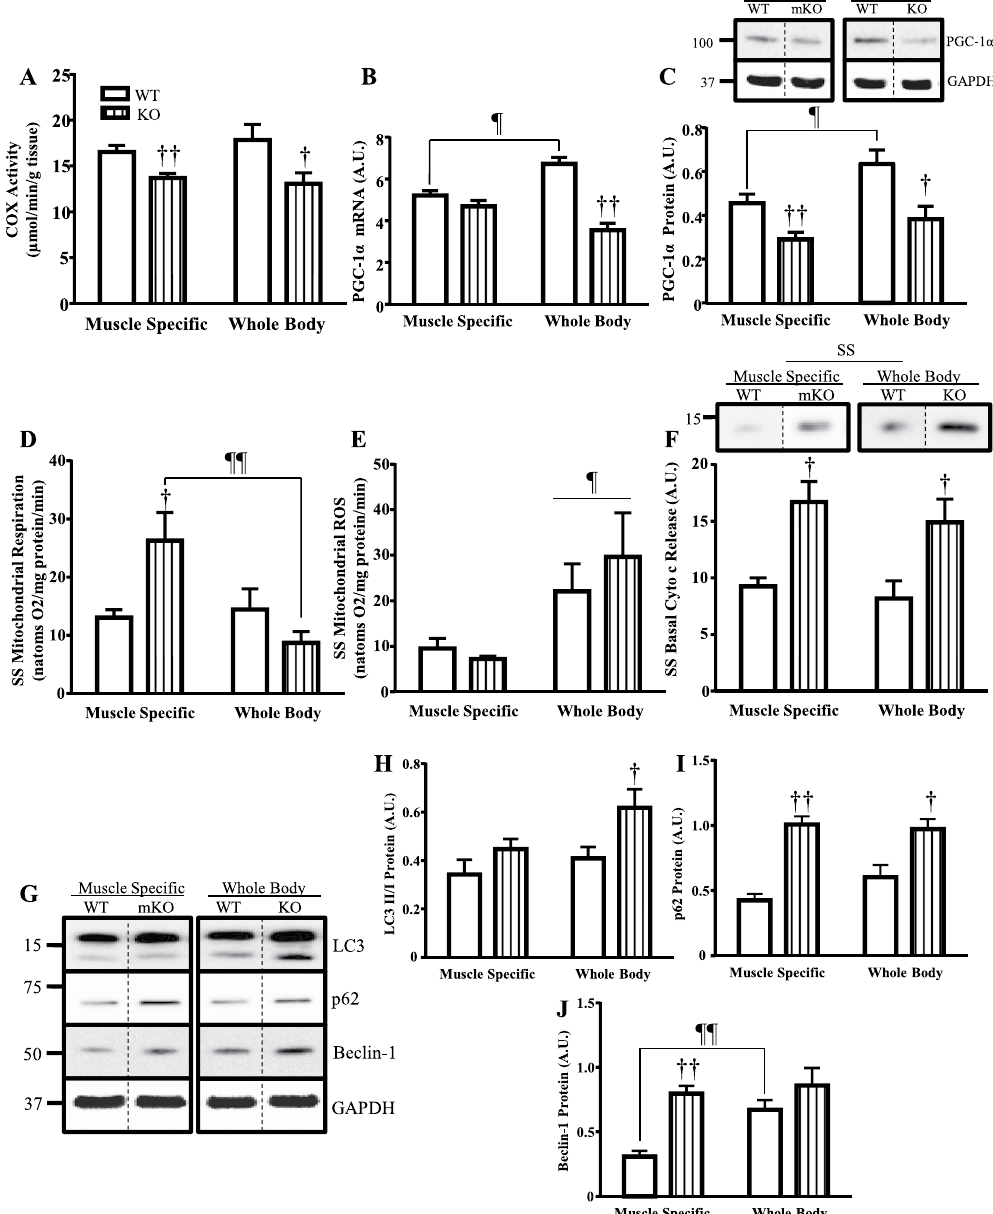
Figure 6. Basal mitochondrial biogenesis, apoptosis, and autophagy signaling comparisons between mouse models. Muscle specific (mKO) and whole body (WB) p53 deletion models were compared under basal conditions. Mitochondrial biogenesis was measured through ( A ) COX enzyme activity (n = 6–8/group); † p ≤ 0.05, †† p ≤ 0.01, UT WT vs. KO, Student’s t-test and 2-way ANOVA, and whole muscle ( B ) PGC-1 α mRNA (n = 5–10/group); †† p ≤ 0.01, UT WT vs. KO, 2; ¶ p ≤ 0.05, WT MS vs. WB, 2-way ANOVA, and ( C ) PGC-1 α protein (n = 5–7/group); † p ≤ 0.05, †† p ≤ 0.01, UT WT vs. KO, Student’s t-test and 2-way ANOVA; ¶ p ≤ 0.05, WT MS vs. WB, Student’s t-test. Immunoblots were retrieved from the same blot but were spliced for direct comparison of untrained animals. Full-length blot is presented in Supplementary Figure 2. SS mitochondrial state 3 ( D ) respiration (n = 6/group); † p ≤ 0.05, UT WT vs. KO, Student’s t-test; ¶¶ p ≤ 0.01, KO MS vs. WB, 2-way ANOVA, and ( E ) ROS emission (n = 6–7/group); ¶ p ≤ 0.05, MS vs. WB, Student’s t-test and 2-way ANOVA, was measured. ( F ) Basal cytochrome c release in SS mitochondria (n = 5–9/group); † p ≤ 0.05, UT WT vs. KO, Student’s t-test and 2-way ANOVA. Immunoblots were spliced for direct comparison of untrained animals. Full-length blot is presented in Supplementary Figure 3. ( G ) Autophagy was further examined through whole-muscle analysis of autophagy proteins including ( H ) LC3-II/LC3-I ratio (n = 6–8/group); † p ≤ 0.05, UT WT vs. KO, Student’s t-test, ( I ) p62 (n = 5–8/group); † p ≤ 0.05, †† p ≤ 0.01, UT WT vs. KO, 2-way ANOVA, and ( J ) Beclin-1 (n = 5–7/group); †† p ≤ 0.01, UT WT vs. KO, 2-way ANOVA; ¶¶ p ≤ 0.01, WT MS vs. WB, Student’s t-test. Immunoblots were retrieved from the same blot but were spliced for direct comparison of untrained animals. Full-length blot is presented in Supplementary Figure 4.Data are presented as mean ±